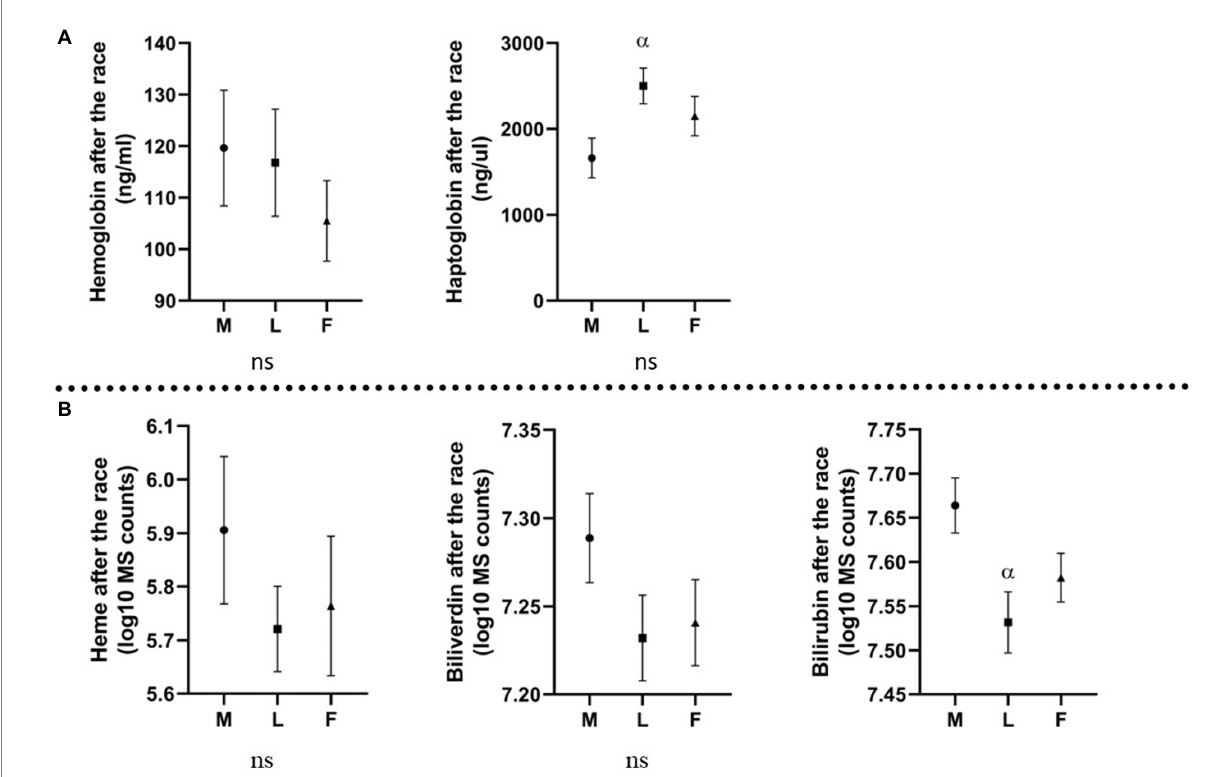
FIGURE 3 Levels of molecules (Mean and standard error of the mean) in horses eliminated for different reasons. M, metabolic eliminations; L, lameness eliminations; F, finishers; (A) molecules analyzed with ELISA, expressed in ng/mL (Hb) and ng/ μ L (Hp); (B) molecules analyzed with metabolomics platform, expressed in log10 MS counts; α : p ≤ 0.05 vs. metabolic